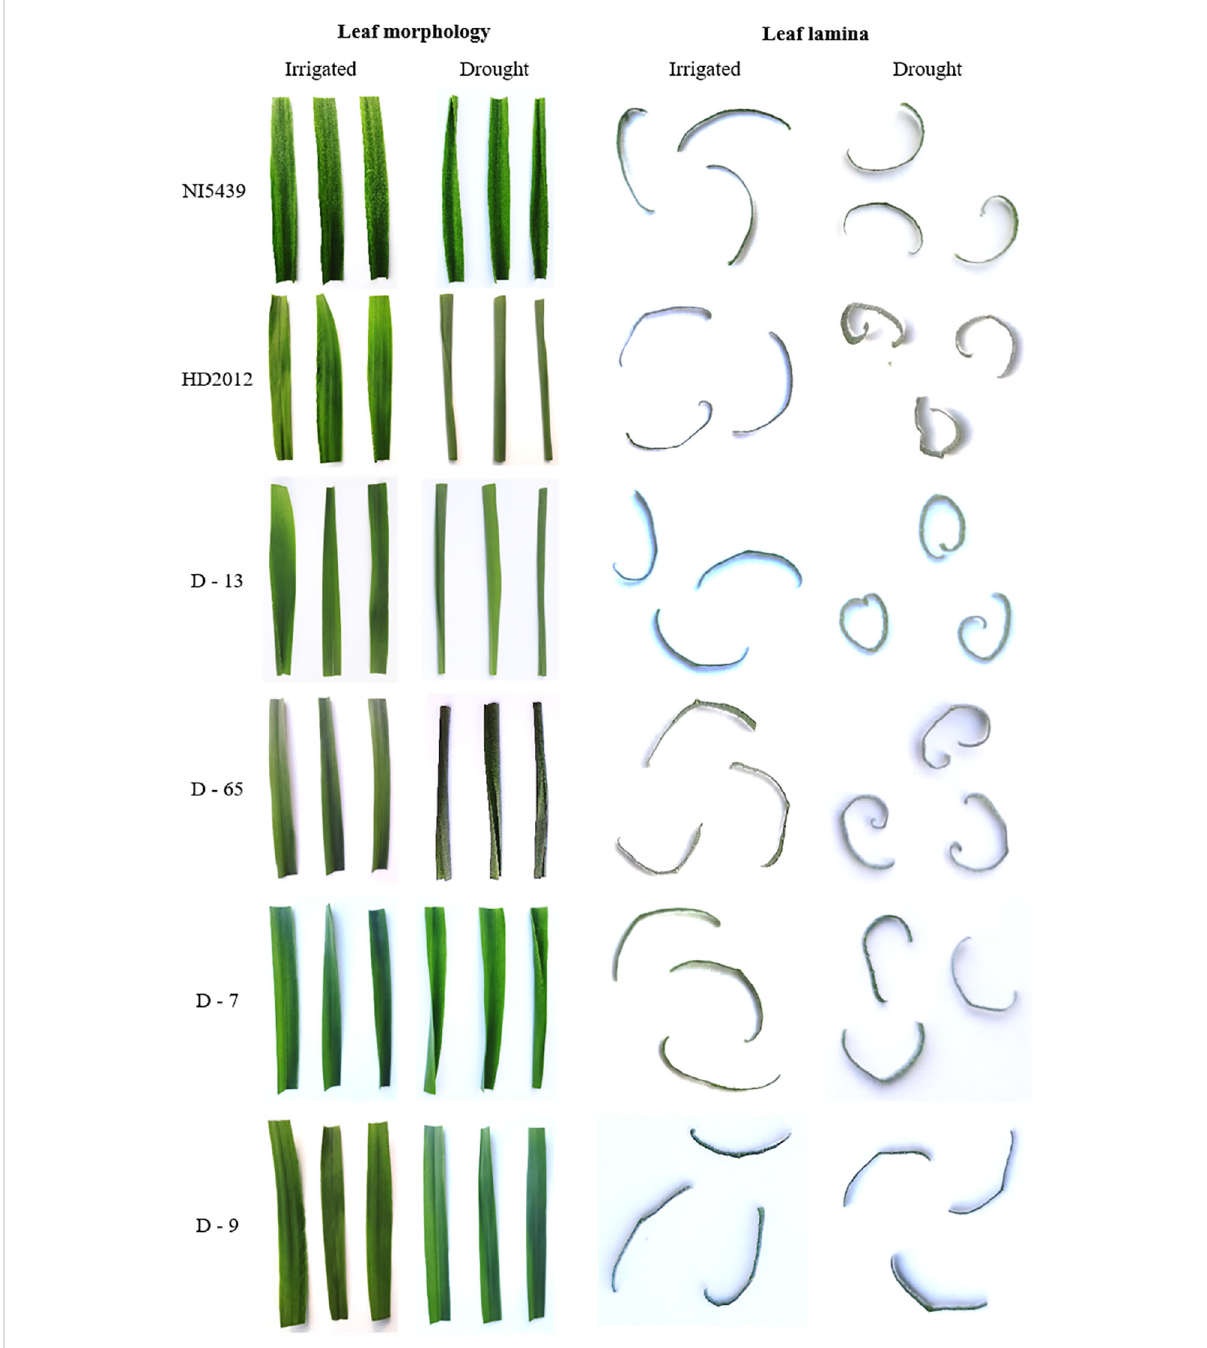
FIGURE 1 Morphological observations of fl ag leaf of wheat RILs with parents for rolling (From top to bottom: NI5439; drought resilient, HD2012; drought susceptible, high LR RILs = D-13 and D-65, and low LR RILs = D-7 and